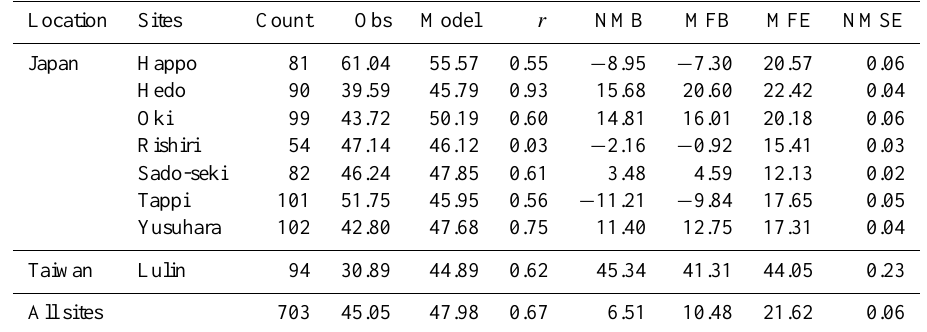
Table 4. Statistical performance of WRF-Chem–REAS simulations for O 3 in 2007. The unit of Obs and Model is ppbv. Other statistical indicators and associated units are described in Table 2.